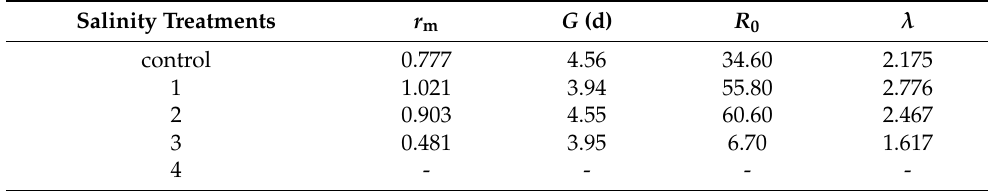
Table 2. The effect of salinity on intrinsic rate of increase, generation time, net reproductive rate and finite rate of increase in S. mucronata